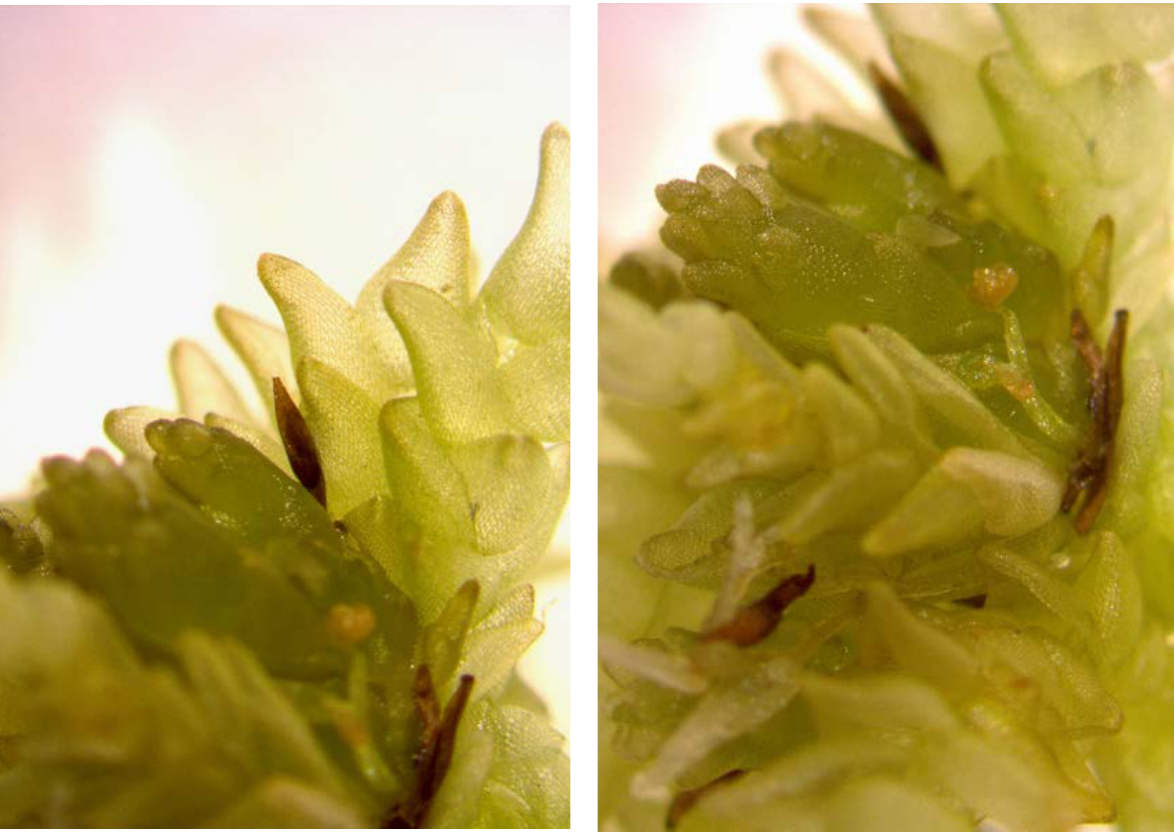
Figure 4. Drosera rotundifolia seeds fixed between the leaves of Sphagnum palustre (left); germinating D. rotundifolia seed (right). Photos: Balázs